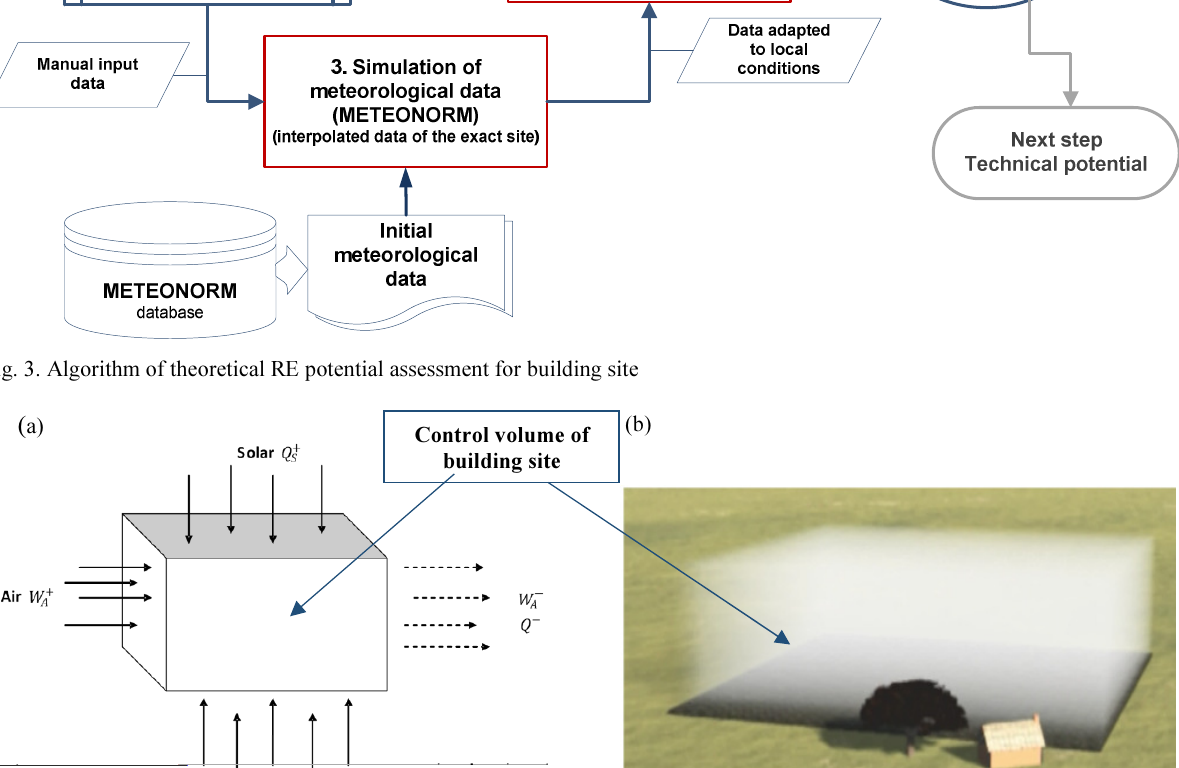
Fig. 4. The energy flows crossing the control volume: (a) RE flow variables, (b) visualization of control volume of the building site